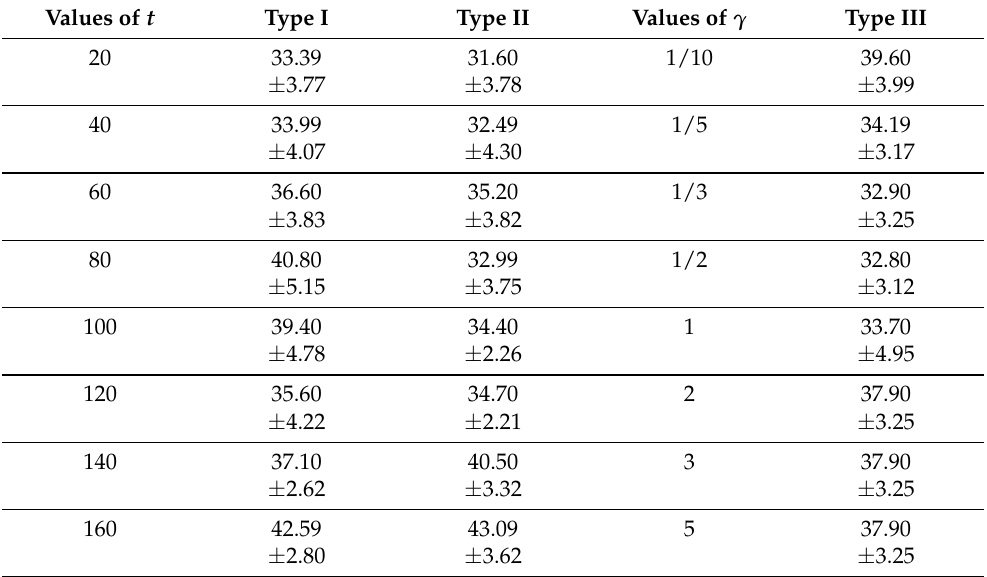
Table 2. Detail of the average error rates of the CNN with image correction methods of type I, II, and III.